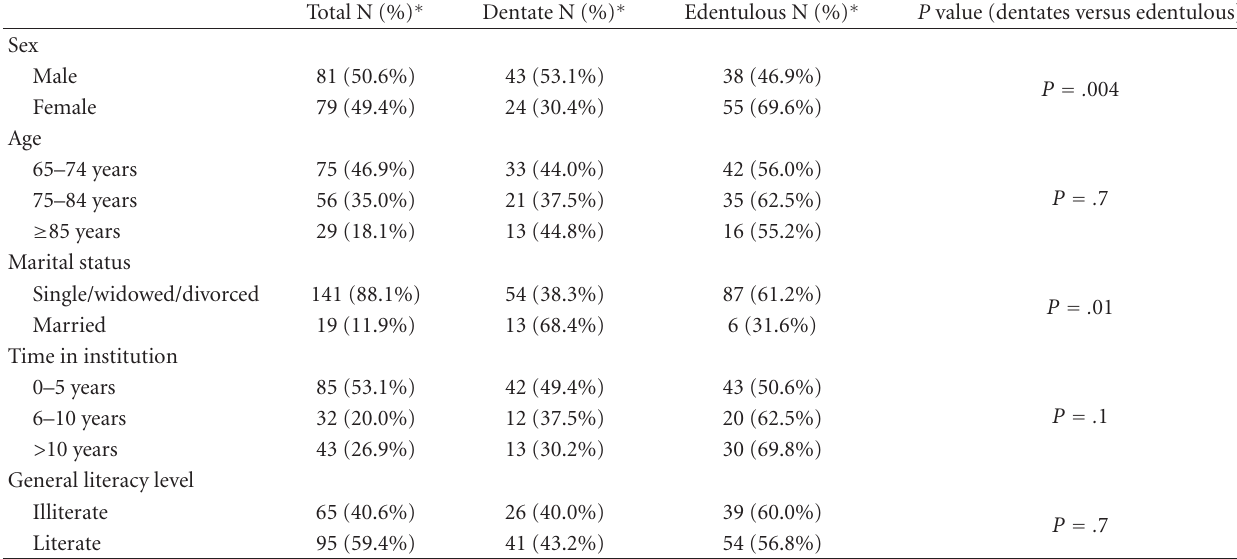
Table 1: Demographic and socioeconomic characteristics of institutionalized older people in northeast Brazil.